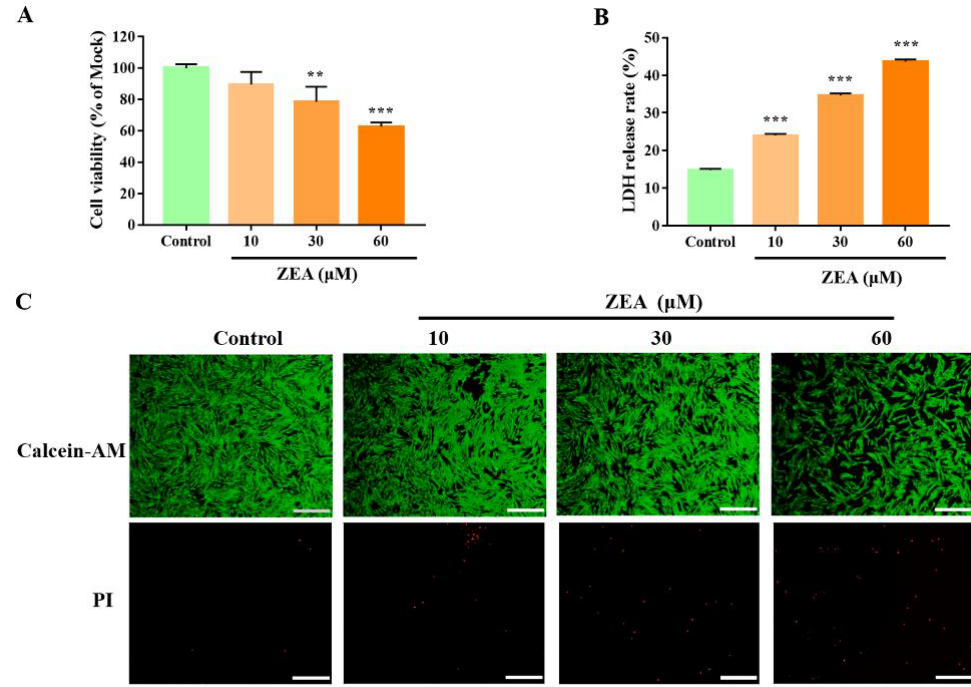
Figure 1. ZEA induces gESCs necrosis. Cells were treated with different concentrations (10, 30, and 60 µ M) of ZEA for 24 h. ( A ) CCK-8 assays of ZEA-treated gESCs. ( B ) LDH release cytotoxicity assays of ZEA-treated gESCs. ( C ) Cell death was assessed by the Calcein-AM/PI staining. Scale bar, 100 µ m. ** p < 0.01, *** p < 0.001 vs. control group.